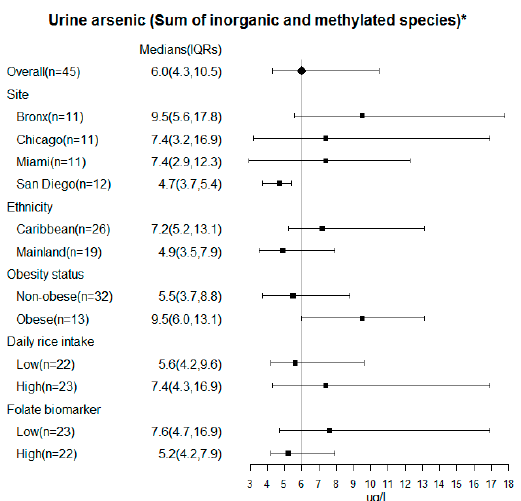
Figure 1. Urinary arsenic not derived from seafood ( ∑ As) in analytes SOLNAS ancillary to HCHS/SOL by site, obesity, rice intake and folate biomarker. * Estimated sum of inorganic and methylated arsenic species applying a residual-based method to remove the impact of seafood arsenicals using urine arsenobetaine, a seafood arsenical that correlates with other seafood arsenicals, based on a method previously validated in Jones et al. (2016). Caribbean includes Cuban, Dominican, Puerto Rican and Mainland includes Mexican, Central American and South American. BMI ≥ 30 kg/m 2 are obese. The rice intake and folate biomarker dichotomized at median 79 g per day and 15.8 ug/L. Table 2. Mean, median, range, and number below limit of detection (LOD) of urinary arsenic (As) species for each analyte by visit in SOLNAS ancillary to HCHS / SOL α